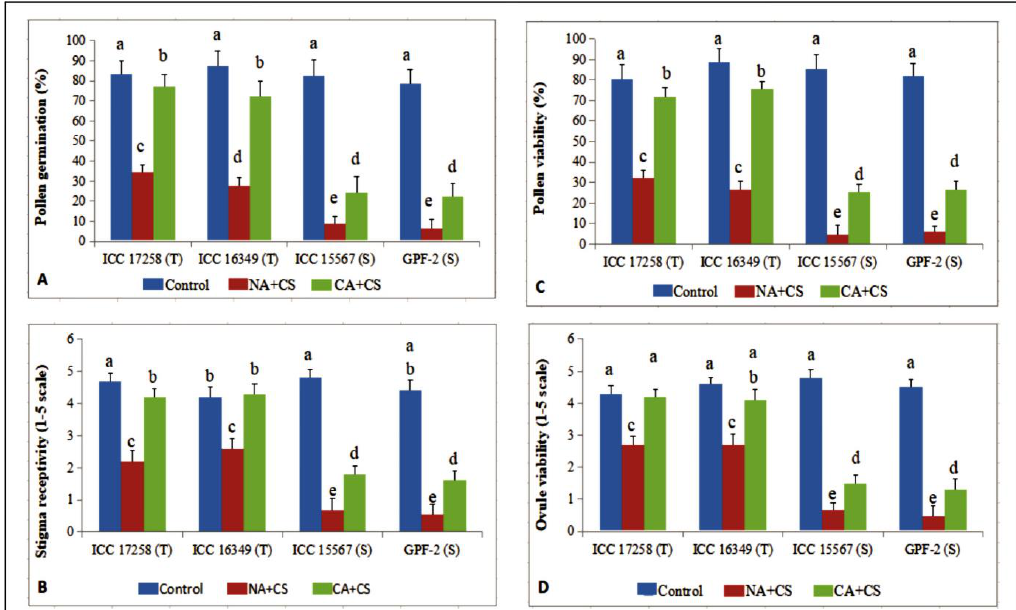
Figure 5. Pollen germination (PG; ( A )), pollen viability (PV; ( C )), stigma receptivity (SR; ( B )) and ovule viability (OV; ( D )) in control, non-acclimated, cold stressed; NA + CS) and cold-acclimated, cold stressed (CA + CS) plants of tolerant (T) and sensitive (S) genotypes. Small vertical bars represent standard errors (Mean ± S.E; n = 3). Different small letters on vertical bars indicate significant differences from each other ( p < 0.05; Tukey’s test). Least significant difference (LSD) for interaction ( p < 0.05) (genotypes × treatments): PG (6.9), PV (7.1), SR (0.39), OV (0.36).